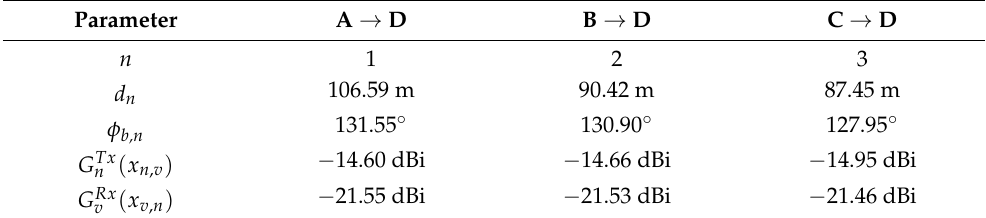
Table 2. Interference Results from Stations A, B, and C, to Station D with and without Diffraction Loss.